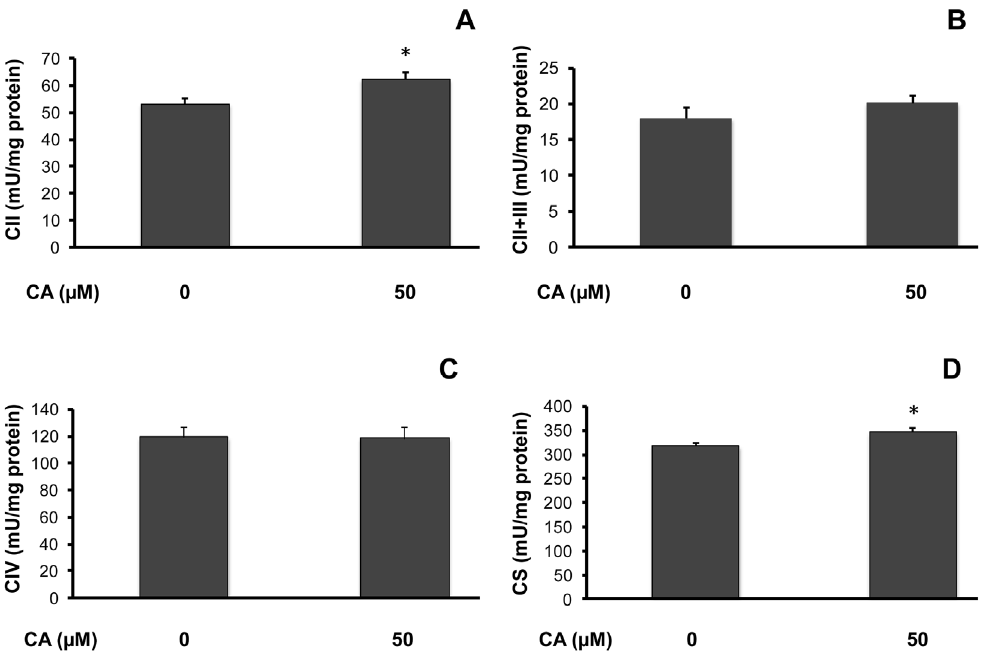
Figure 4. Influence of chicoric acid on mitochondrial activity in L6 myotubes. Cells were cultured in the presence or absence of 50 m M CA for 10 days before measurement of mitochondrial activities. Figure 4 illustrates complex II maximal activity (CII; A ); complexes II + III maximal activity (CII + III; B ); complex IV maximal activity (CIV; C ); and citrate synthase maximal activity (CS; D ). Enzymatic activities are expressed as mU/mg protein and indicated as means 6 SEM (n=5); significantly different from control at * p , 0.05.